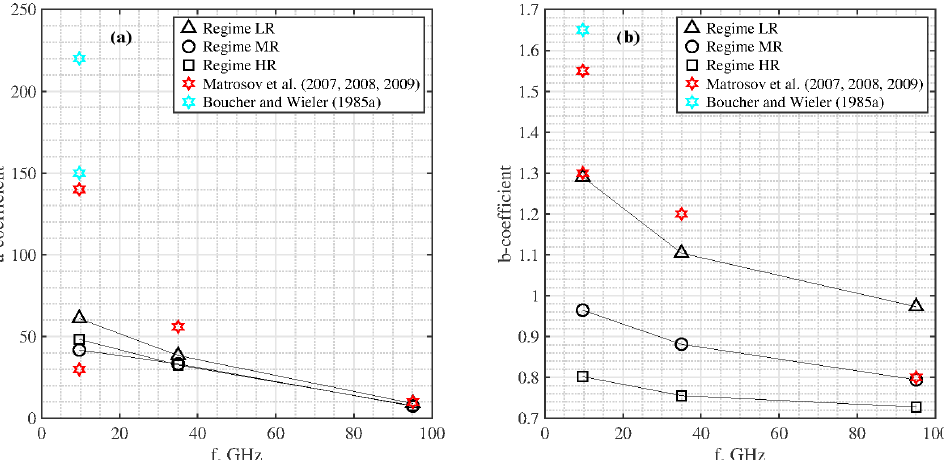
Figure 7. Frequency trend for the a (a) and b (b) regression coefficients, estimated in Table 2 using the power-law form Z e = aS b for the four studied snowfall cases divided into LR, MR and HR.